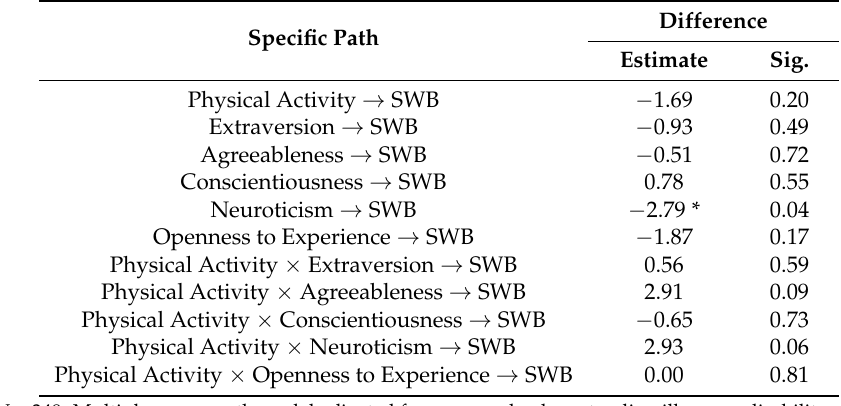
Table A1. Differences between the HK group and the UK group for the tested paths in the multiple-group path